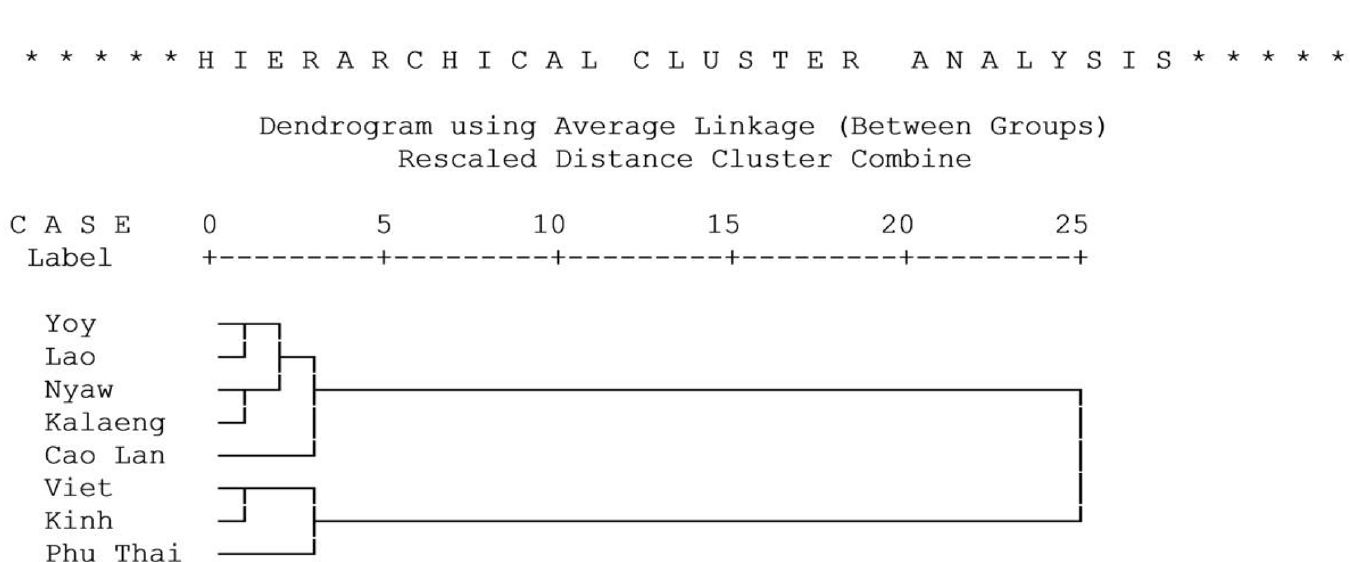
Fig 5. Hierarchical cluster analysis based on percentages of modal characteristics of structural dimensions of homegardens of ethnic groups in Northeast Thailand and Vietnam.